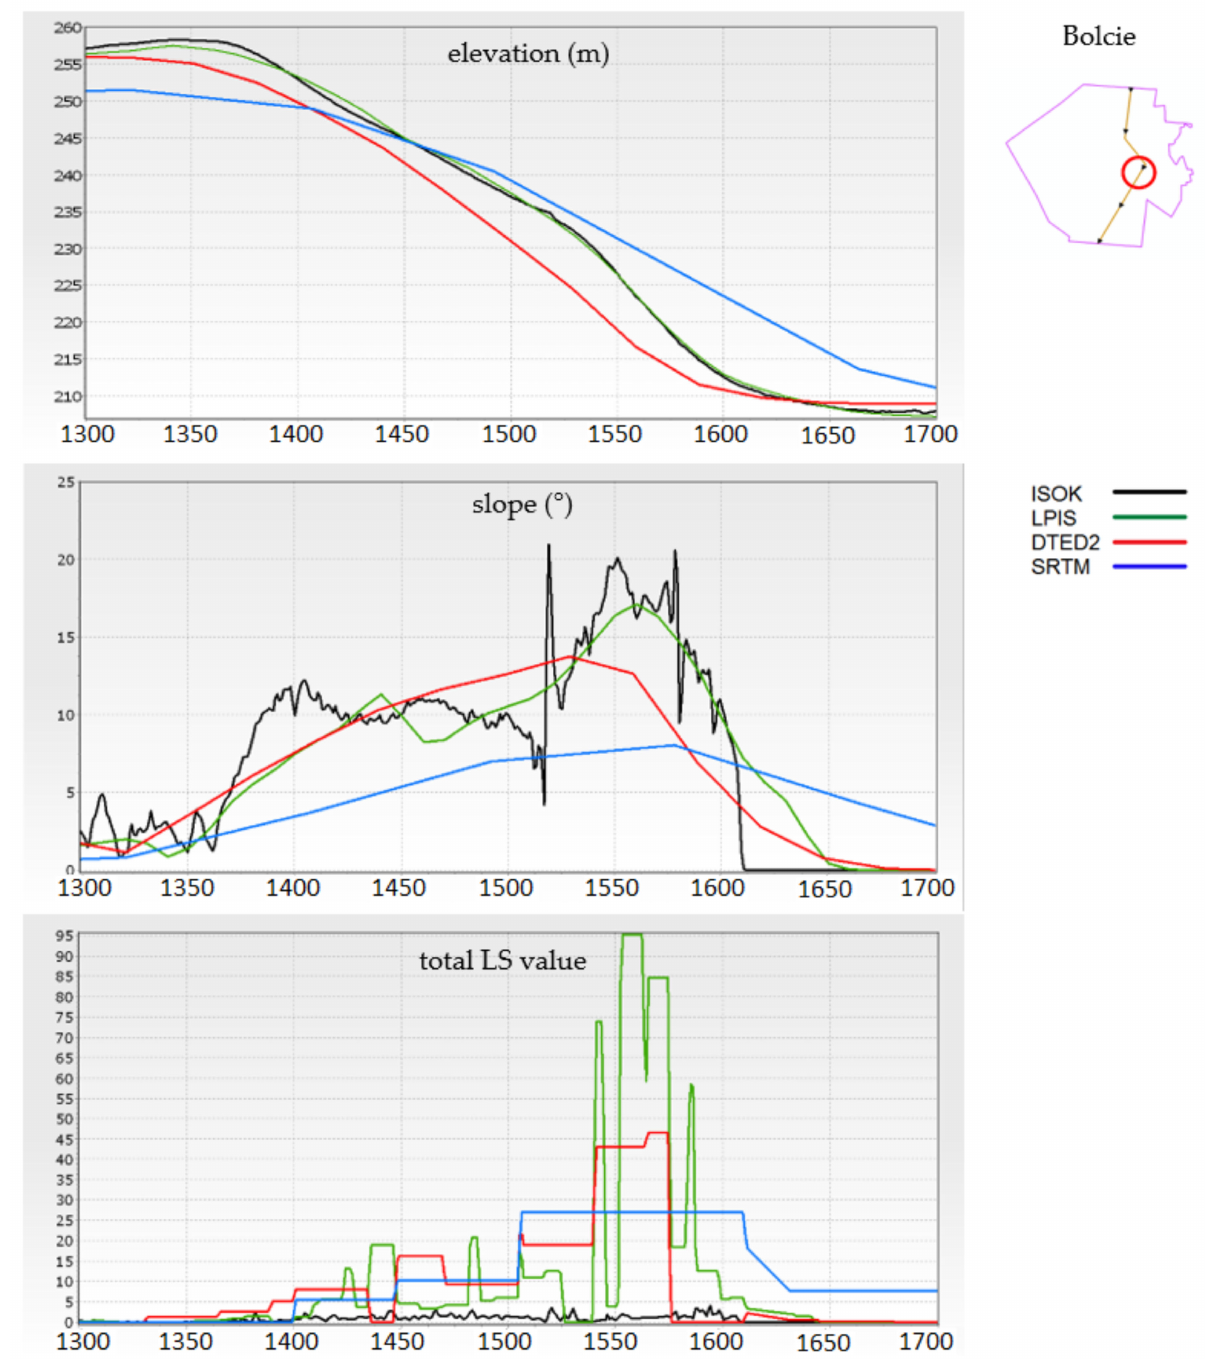
Figure A4. Visualisation of the elevation (m), slopes ( ◦ ) and the total LS factor values (Y-axis) calculated from all the DTM sources for a selected section of the profile (over a 400-m section) for the Bolcie research